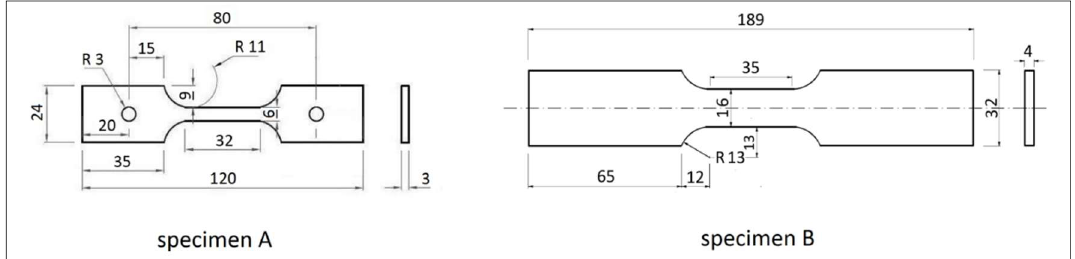
Figure 4. Schematic drawing of specimens for tensile and creep tests (unit: mm).